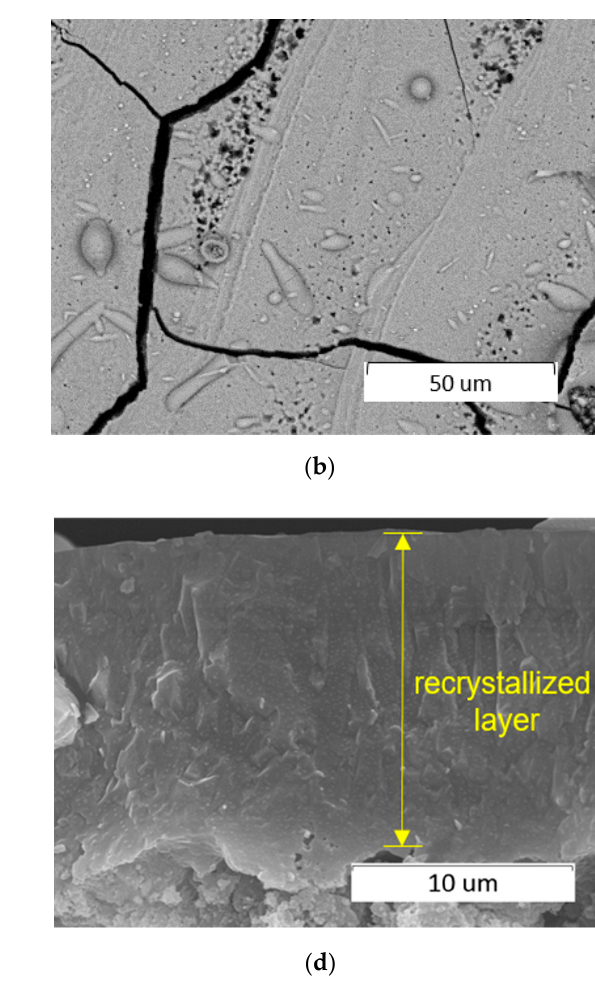
Figure 8. SEM images of surface ( a , b ) and cross-section ( c , d ) of the pellets treated by a 0.2 mm laser spot at 4 W and at scanning speeds of 500 mm/s ( a , c ) and 200 mm/s ( b , d ).